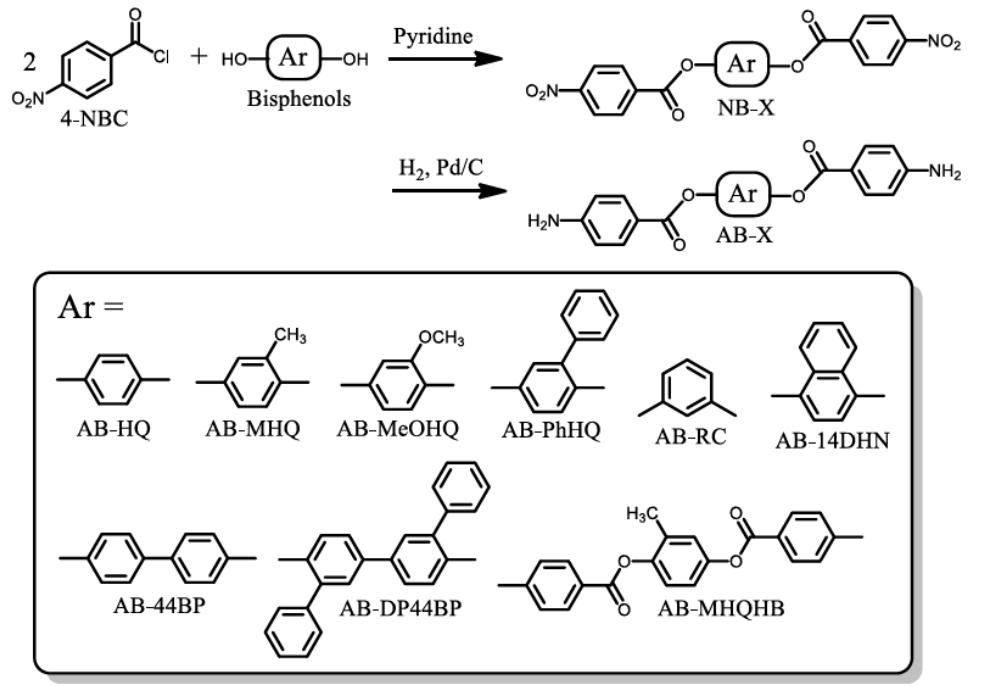
Figure 2. Reaction scheme for the synthesis of ester-linked diamines with different substituents.